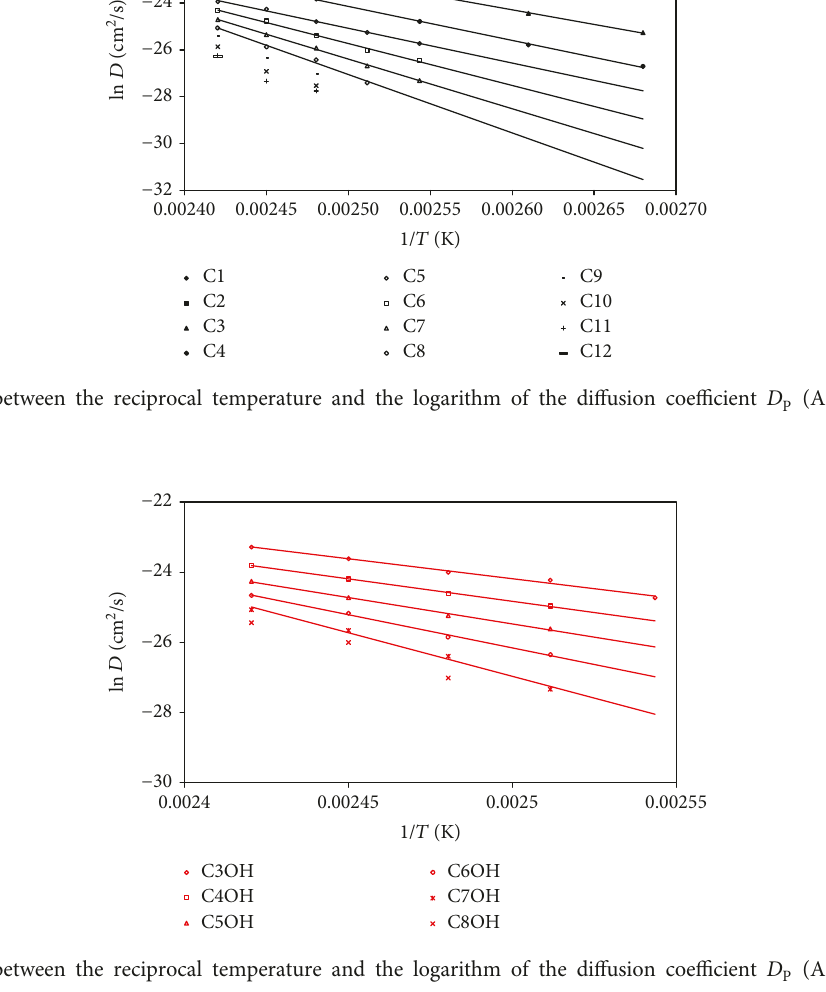
(Arrhenius plot) for the P